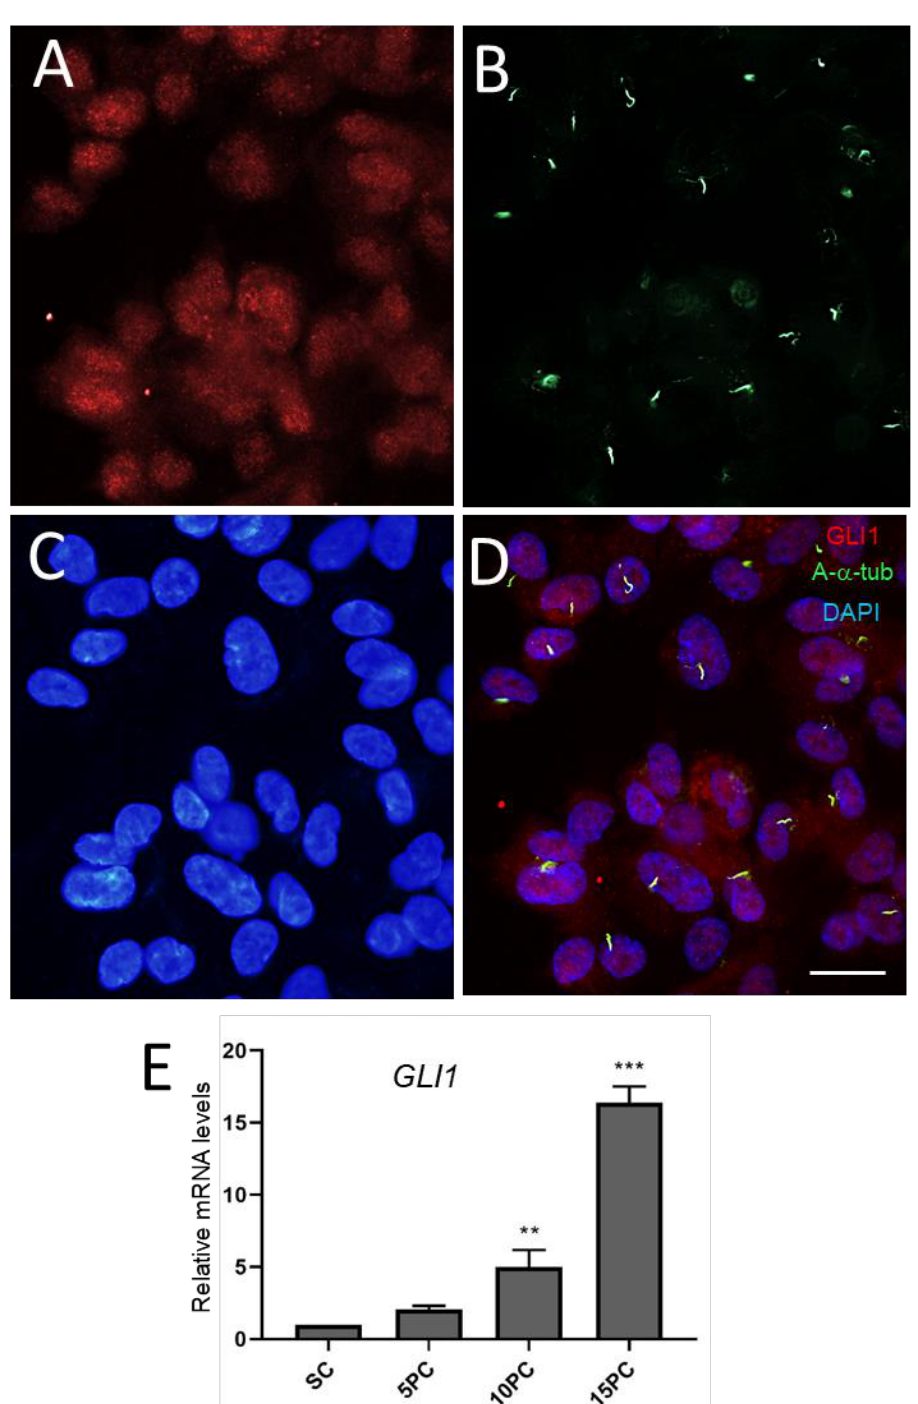
Figure 12. Accumulation of GLI1 expression in quiescent HIEC cells. ( A – D ): Representative indirect immunofluorescence for the detection of GLI1 ( A , D , red staining) and acetylated- α -tubulin (A- α - tub; B , D , green staining) in post-confluent HIEC cells. Nuclei were stained with DAPI ( C , D ). Scale bar is equal to 10 µm. ( E ): GLI1 transcript expression in subconfluent (SC) and 5-, 10- and 15-day post-confluent (5PC, 10PC and 15PC) HIEC-6 cells. **, p < 0.01; ***, p < 0.0005.